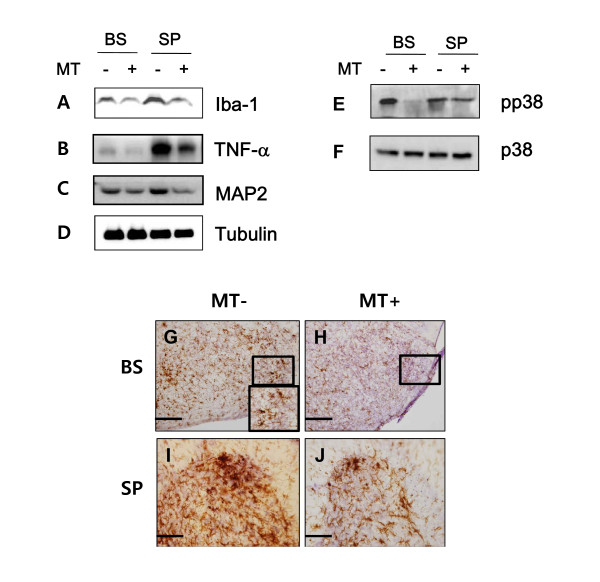
Western blot and immunohistochemical detection of anti-neuroinflammatory events in the brainstem and spinal cord. The western blot image is representative of three independent experiments. A representative blot of Iba-1 (A) or TNF-α (B) demeonstrates a significant reduction in the expression of these molecules in the brainstem and spinal cord of melittin-treated hSOD1G93A mice. The expression of MAP2 (a neuron marker) is dramatically increased in both the brainstem and spinal cord of melittin-treated hSOD1G93A mice compared with saline-treated hSOD1G93A mice (C). α-tubulin was used for loading control. The activation of p38 is increased in the brainstem and spinal cord of hSOD1G93A mice, but melittin-treated hSOD1G93A mice showed reduced expression of phospho-p38 (E). The expression of p38 was used as a comparison for the expression of activated phospho-p38. Selected free-floating fifth spinal cord or brainstem section (40 μm) from saline- (n= 3) or melittin-treated hSOD1G93A mice (n= 4) was stained with an anti-Iba-1. The immunohistochemical study of Iba-1 in the facial nucleus of the brainstem and the anterior horns of the lumbar (L4) spinal cord confirmed that melittin treatment reduced the number of Iba-1-expressing cells in the hSOD1G93A mice compared to age-matched control mice (G-J). The large box presents higher magnification views of the small box in the facial nucleus region of the brainstem in control hSOD1G93A mice (G). Scale bars = 200 μm (G, H). Scale bars = 100 μm (I, J). MT: melittin, BS: brainstem, SP: spinal cord.